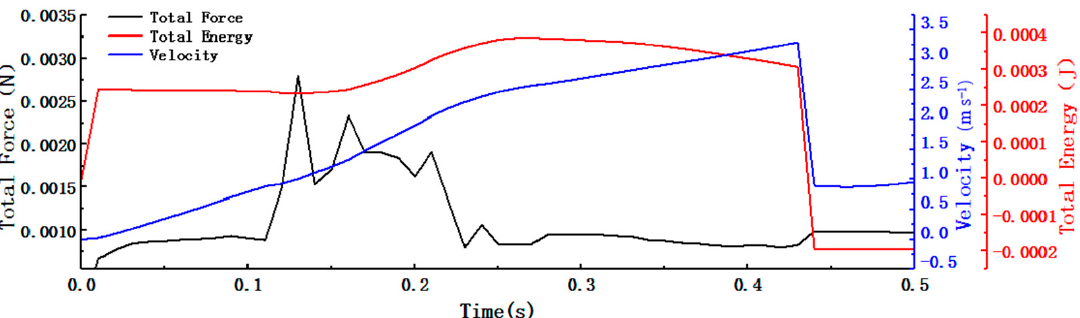
Figure 9. Force (black line), kinetic energy (red line), and velocity (blue line) of tea material.